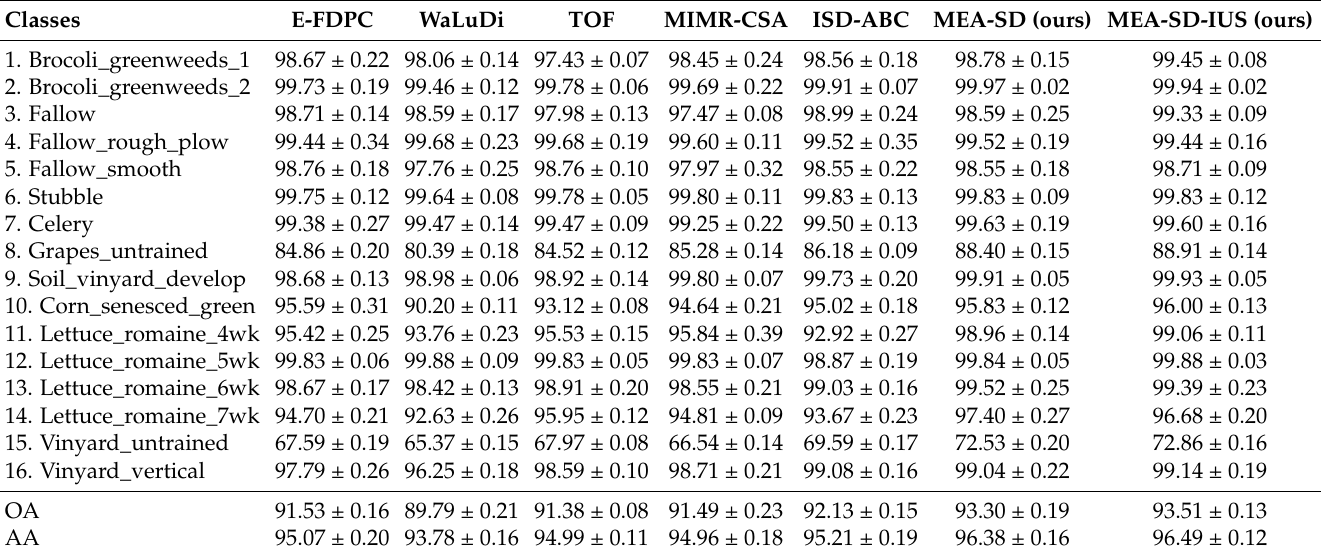
Table 7. The detailed classification accuracies (%) of different methods on Salinas dataset.